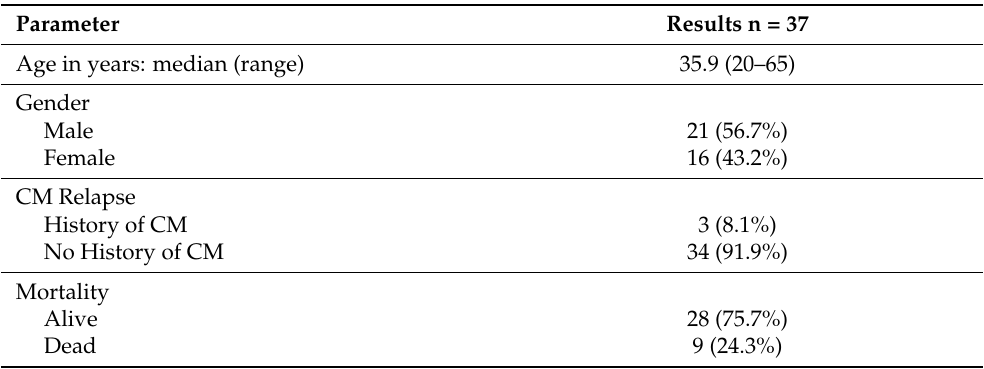
Table 2. Characteristics of the 37 study patients whose isolates were selected for ERG11